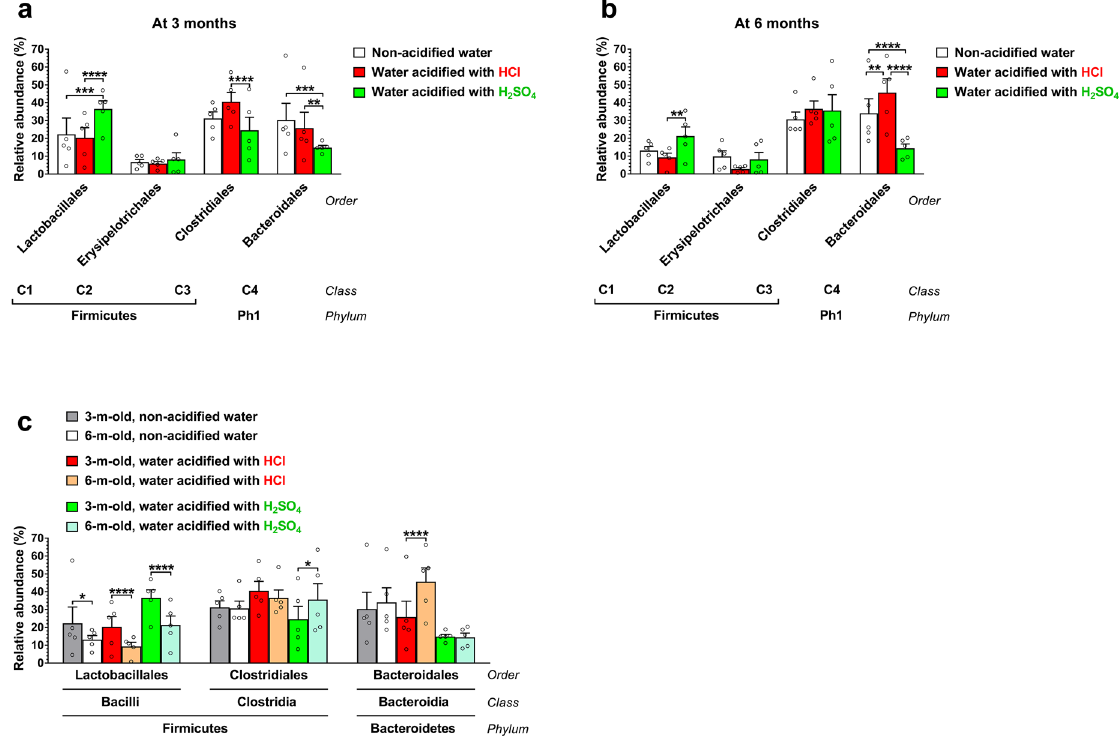
Figure 4. Drinking water acidified with H 2 SO 4 alters the order composition of the gut microbiota differently than water acidified with HCl. 129S6/SvEv male mice were either kept on non-acidified drinking water or received drinking water acidified with H 2 SO 4 or HCl from weaning (postnatal day 21). Fecal pellets were collected at 3 and 6 months of age to analyze the gut microbiota by 16S rRNA gene sequencing. ( a )–( b ) Differential effects of H 2 SO 4 -acidified and HCl-acidified drinking waters on the gut microbiota composition at the order taxonomic level at 3 ( a ) and 6 months ( b ) of age. ( c ) Age-dependent changes (from 3 to 6 months) in the order composition of the gut microbiota. Columns and bars represent mean ± SEM and the circles show the individual data (n = 5 mice, from 4 to 5 different cages for each group). Statistical significance was determined by 2-way ANOVA with Bonferroni’s post-test for multiple comparisons: * p < 0.05; ** p < 0.01; *** p < 0.001; **** p < 0.0001. Ph1, Bacteroidetes ; C1, Bacilli ; C2, Erysipelotrichia ; C3, Clostridia ; C4, Bacteroidia